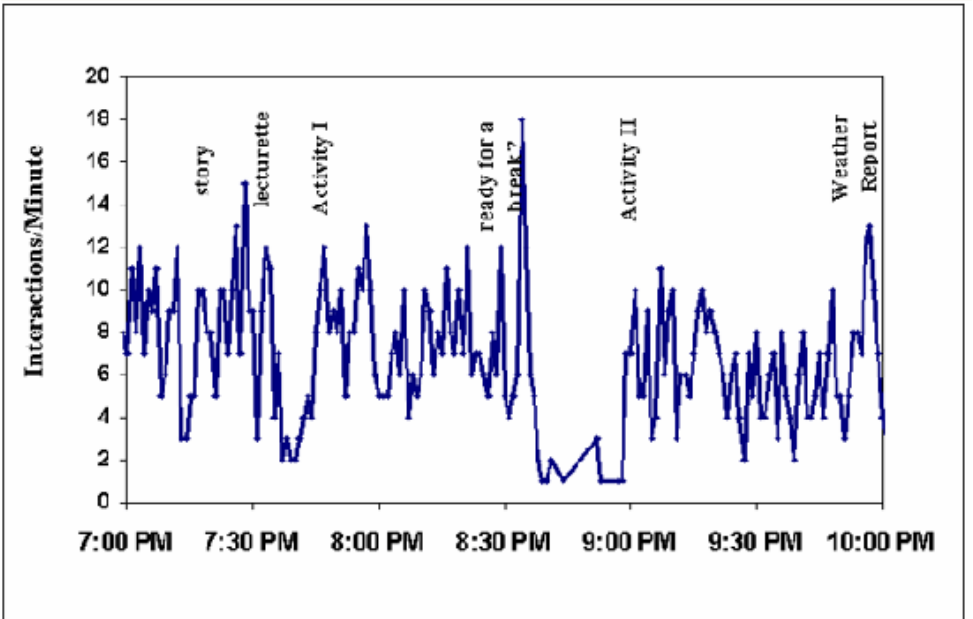
Figure 12. Level of Interactions during the Oct 10 Learning Management